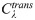
A spectrum of communication processes.(a) Averages of Cλtrans (red) and Cλinfo (blue) across all node pairs, as a function of λ. Solid red and blue lines correspond to the median across all subjects, whereas the shaded red and blue regions denote the 95th percentile. (b) Averages of ‖Cλtrans‖ (red) and ‖Cλinfo‖ (blue) across all node pairs. These curves are computed by normalizing Cλtrans and Cλinfo with respect to the same cost measures computed on ensembles of 500 randomized networks (per subject). Shaded red and blue areas indicate sections of the curves ‖Cλtrans‖ and ‖Cλinfo‖ that are smaller than 1, respectively, indicating the regions in the spectrum where the communication cost of empirical networks (i.e. networks that are derived from empirical data) is smaller than the cost computed on the randomized ensembles. The dashed vertical lines are placed at the minimum and maximum of ‖Cλtrans‖ (λ2 and λ3, respectively), and at two points near the extremes of the spectrum (λ1 and λ4). (c) pairwise values of Cλtrans(i,t) for all node pairs. (d) pairwise values of Cλinfo(i,t) for all node pairs. In all panels, λ1 = e-4.49, λ2 = e-1.64, λ3 = e0.37 and λ4 = e1.79.